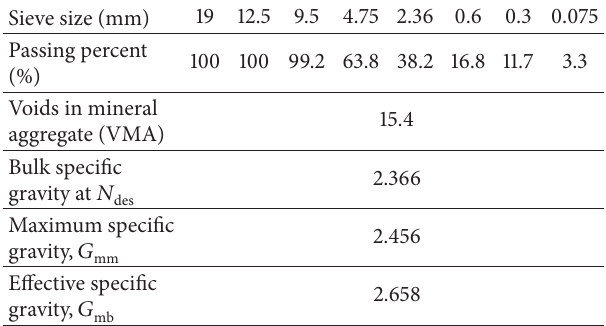
Table 2: Aggregate gradation and mixture volumetric